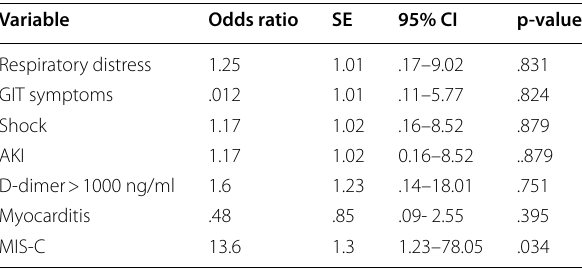
Table 4 Binary logistic regression analysis for predictors of